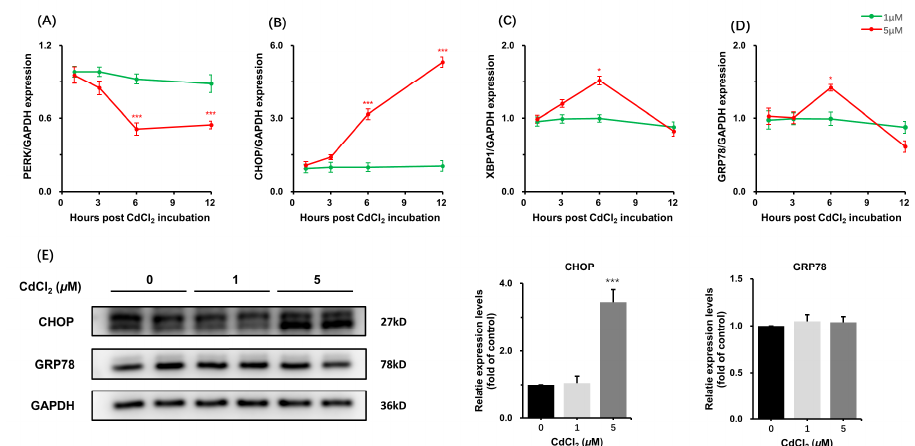
Figure 2. CdCl 2 treatment induced the endoplasmic reticulum stress in the Sertoli cell. The mRNA levels of ( A ) PERK, ( B ) CHOP, ( C ) XBP1, and ( D ) GPR78 were measured by using qPCR at 1, 3, 6, and 12 h after treatment with CdCl 2 (1, 5 µ M). The protein levels of CHOP and GRP78 at 12 h were evaluated by immunoblotting ( E ). * p < 0.05 compared to the control group, *** p < 0.001 compared to the control group.